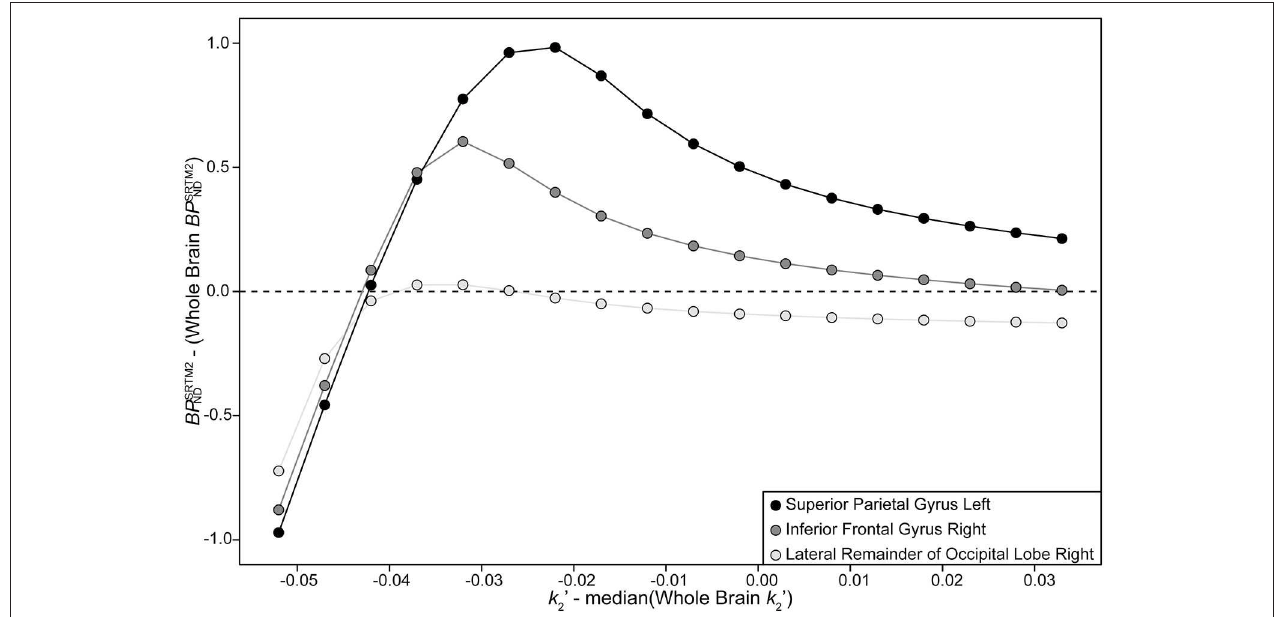
FIGURE 4 | Plot of the relative changes in BP SRTM 2 ND with relative increment of k ′ 2 . In the x-axis is the fixed value of k ′ 2 (which varied from 0.005 to 0.09 with a step of 0.005) minus the median k ′ 2 from the data of all subjects for the Whole Brain method. In the y-axis is the BP SRTM 2 ND of the fixed k ′ 2 value of a specific brain region minus the value of the same region for the Whole Brain method. The dashed line represents a difference in BP SRTM 2 ND of zero. Black dots represent data from the Superior Parietal Gyrus left region (a region with high PIB binding), in dark gray, the Inferior Frontal Gyrus right (a region with medium binding), and in light gray, the Lateral Remainder of Occipital Lobe right (a region with low binding of